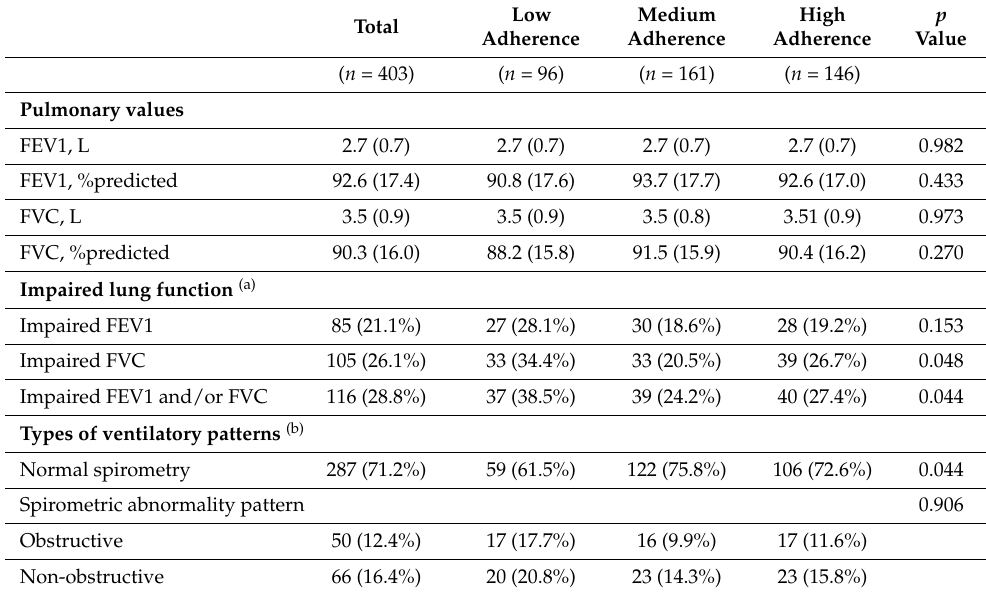
Table 2. Lung function according to the degree of the Mediterranean Diet Adherence (*).